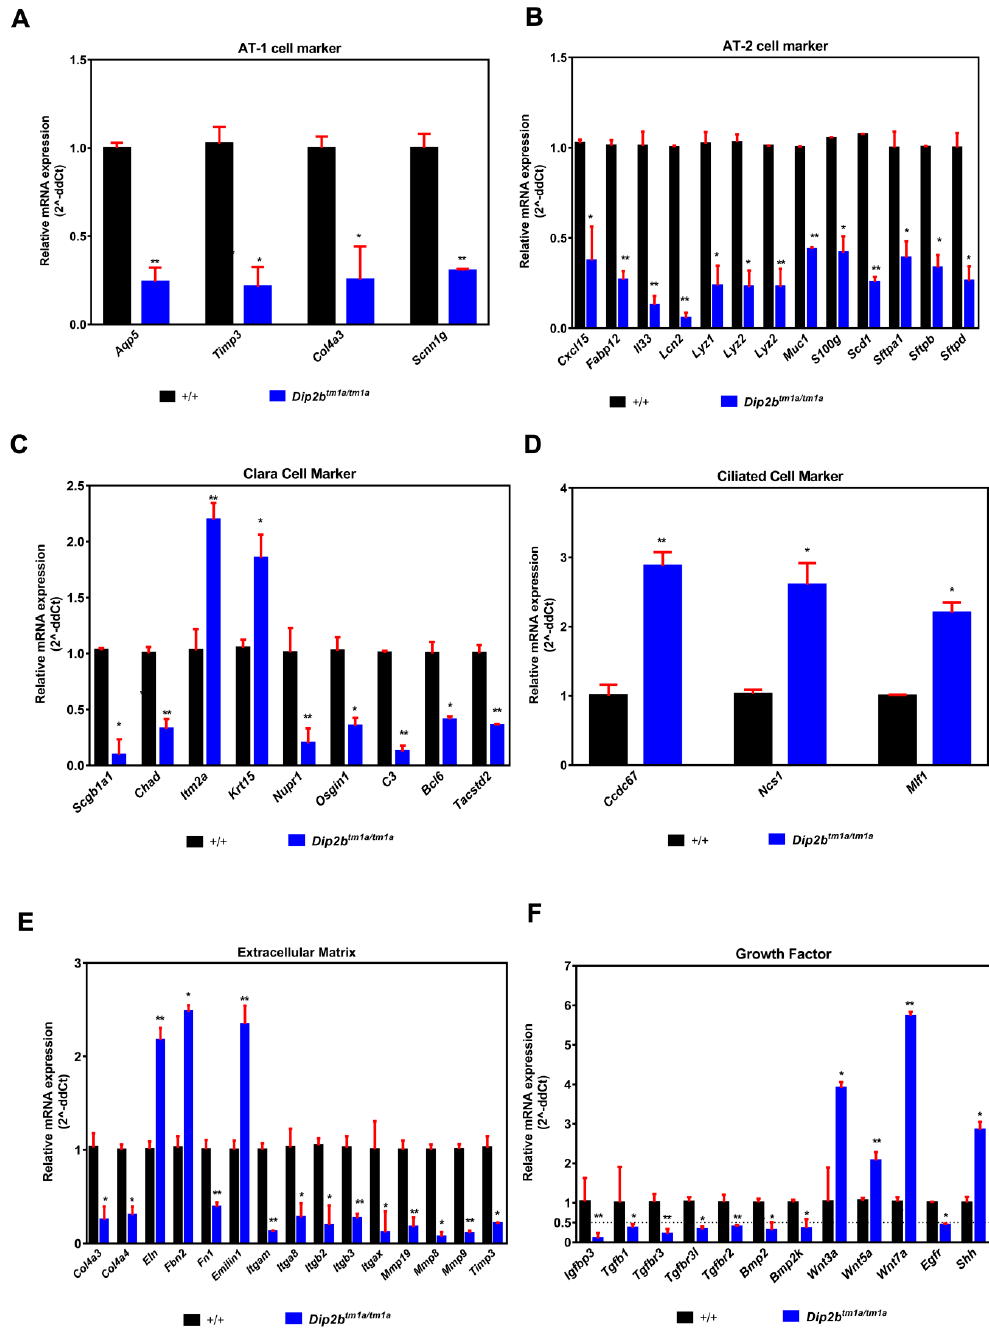
Figure 7. ( A – F ) Gene expression analysis of alveolar, bronchiolar cell markers and lung mediator genes by qPCR of E18.5 lungs. Mix of total RNAs from three pups were analyzed per group. Data are means ± SD ( n = 3, * p < 0.05 and ** p < 0.001).